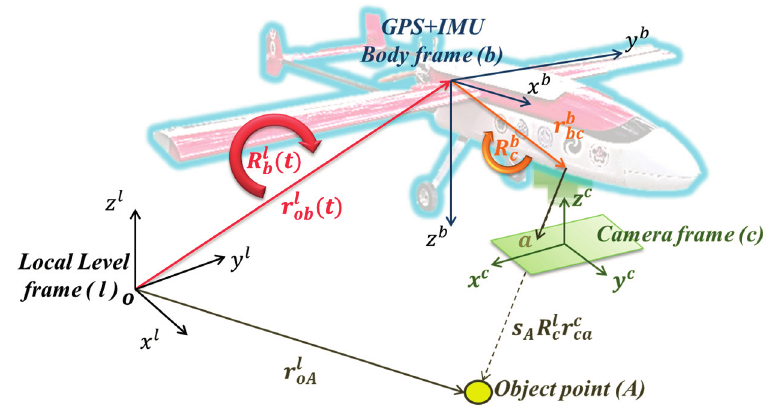
Figure 3. The concept of airborne DG.